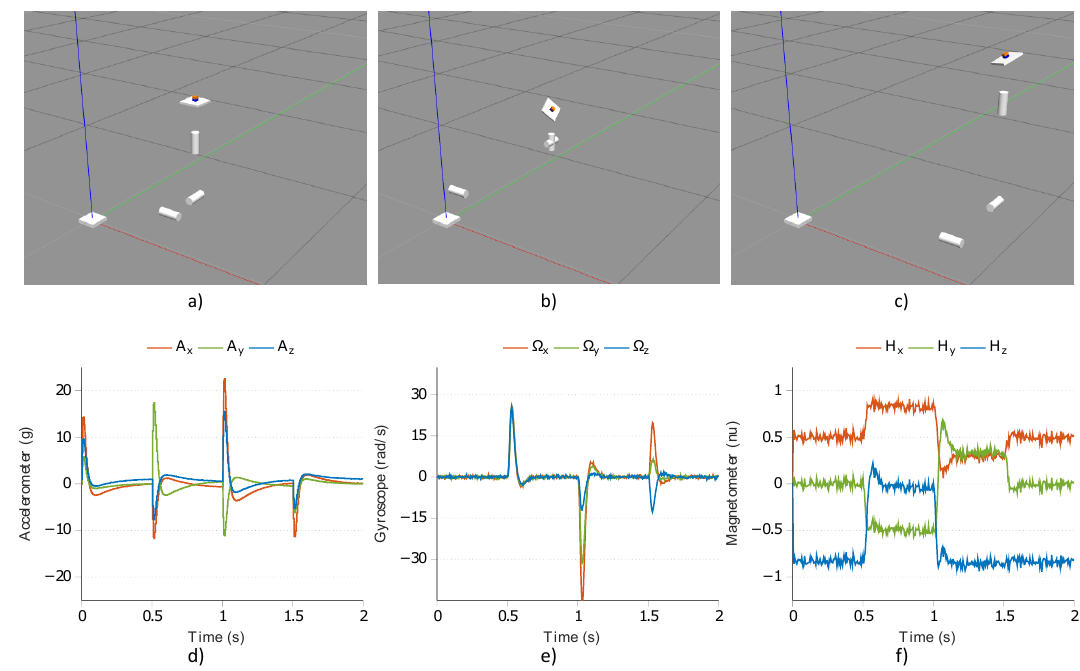
Figure 2. ( a – c ) Snapshots during the motion of the 6 six-degrees of freedom (6 DOF) platform; ( d – f ) raw measurements of the attached magnetic, angular rate, and gravity (MARG)